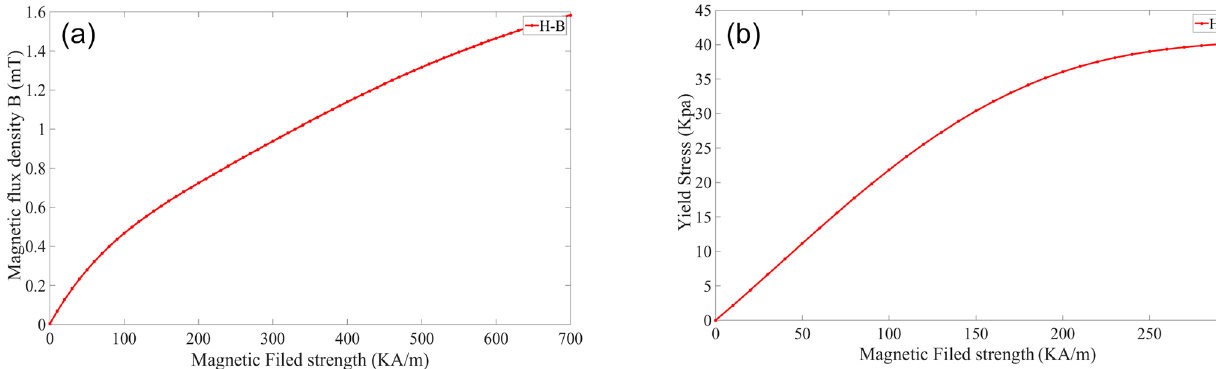
Figure 3. Characteristic of MR fluid (a) B – H curve and (b) τ – H curve.